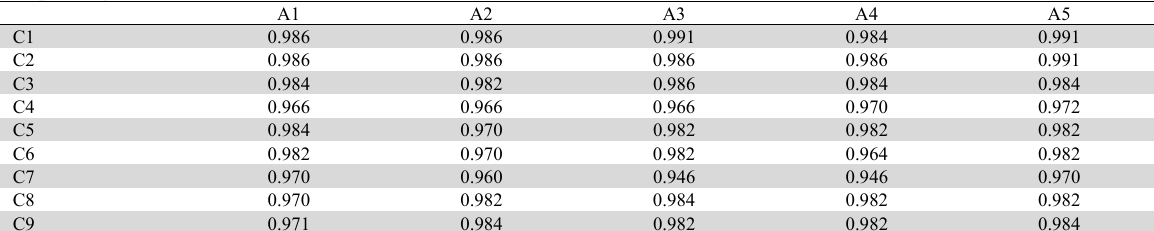
Crisp rating of the measures